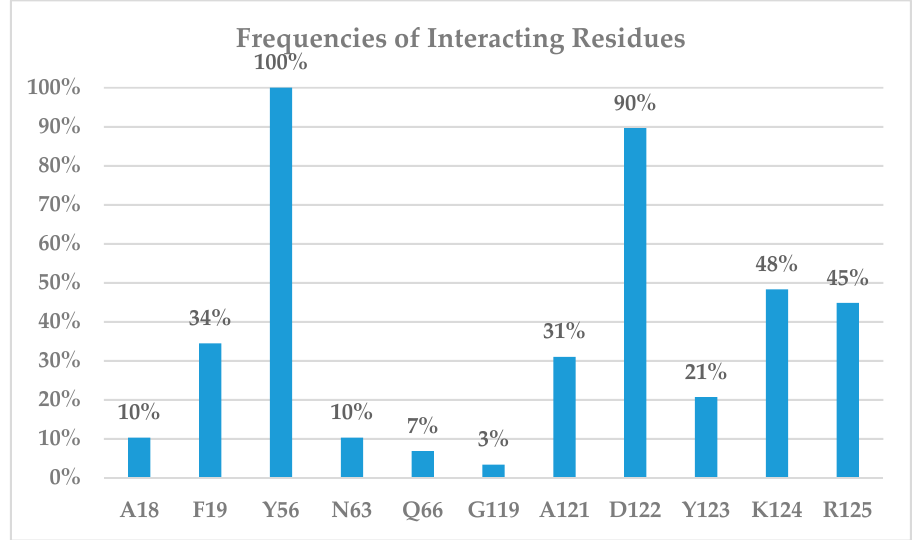
Figure 8. Interacting residues of PD-L1 with all 29 different inhibitors in the 5NIU model.